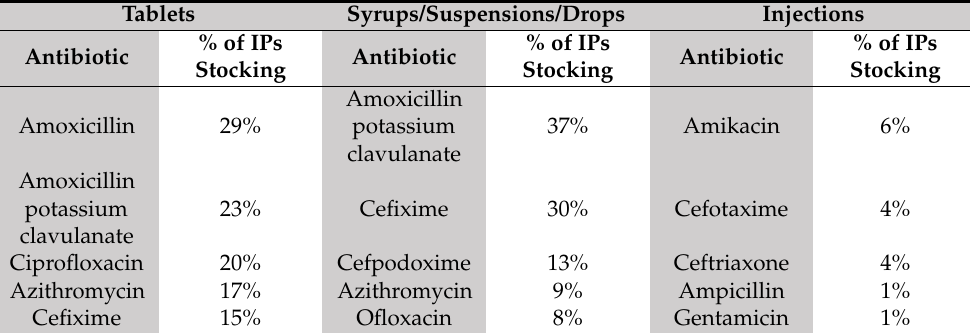
Table 2. Top 5 antibiotic active ingredients stocked by IPs, by formulation ( n = 196).